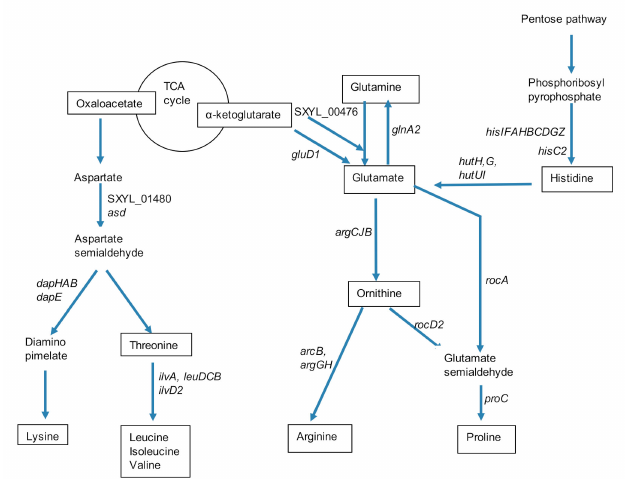
Figure 2. Summary of synthesis pathways for amino acids of the glutamate and aspartate families and for histidine by Staphylococcus xylosus in solid dairy matrix showing the overexpressed genes (the level of expression of these genes and the name of the corresponding enzymes are given Table